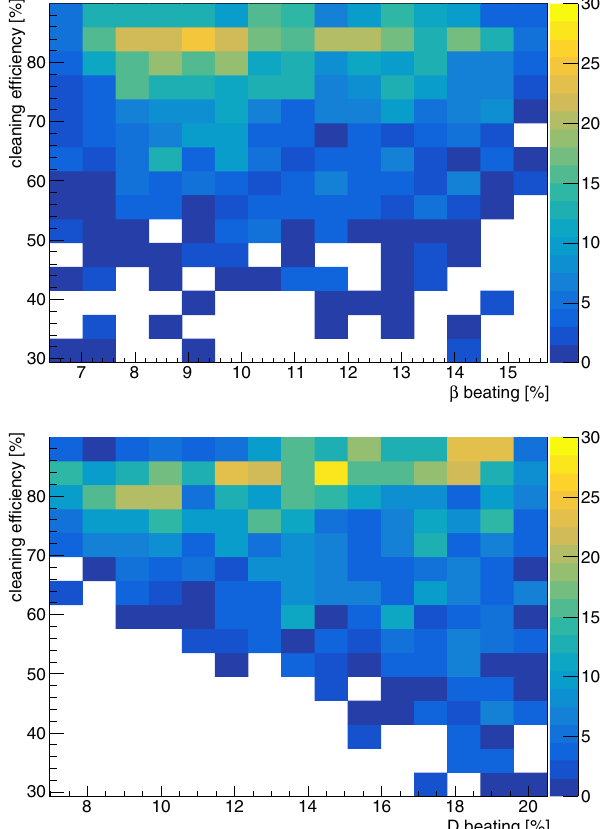
FIG. 13. Distribution of machines attaining a given global cleaning efficiency as a function of β -beating (top) and D-beating (bottom).